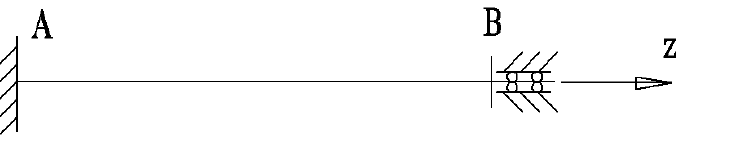
Figure 6. Constraint diagram of torsional thin-walled bar with open cross-section.